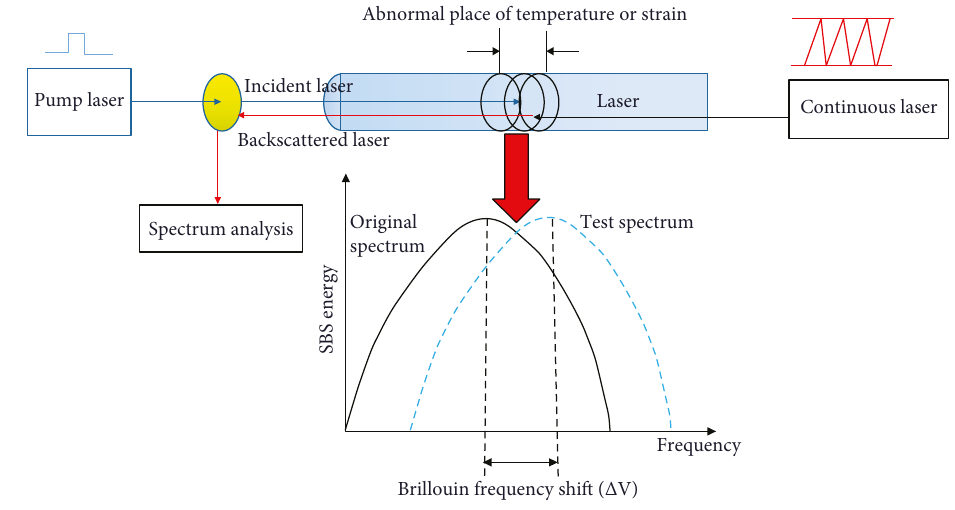
Figure 3: Basic principle diagram of BOTDA.